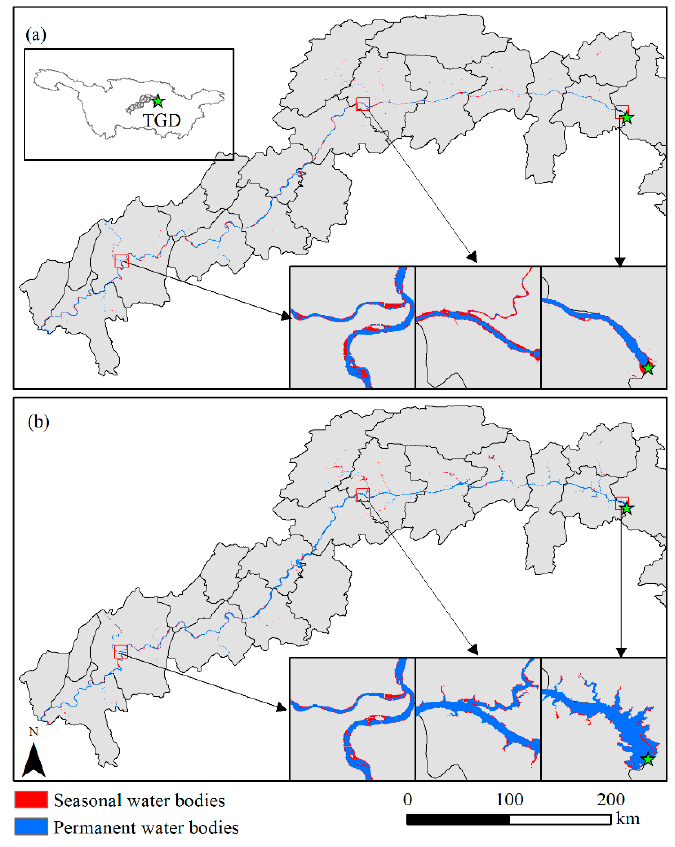
Figure 15. Open-surface water bodies ( a ) before (1984–2002) and ( b ) after (2003–2018) the TGD.